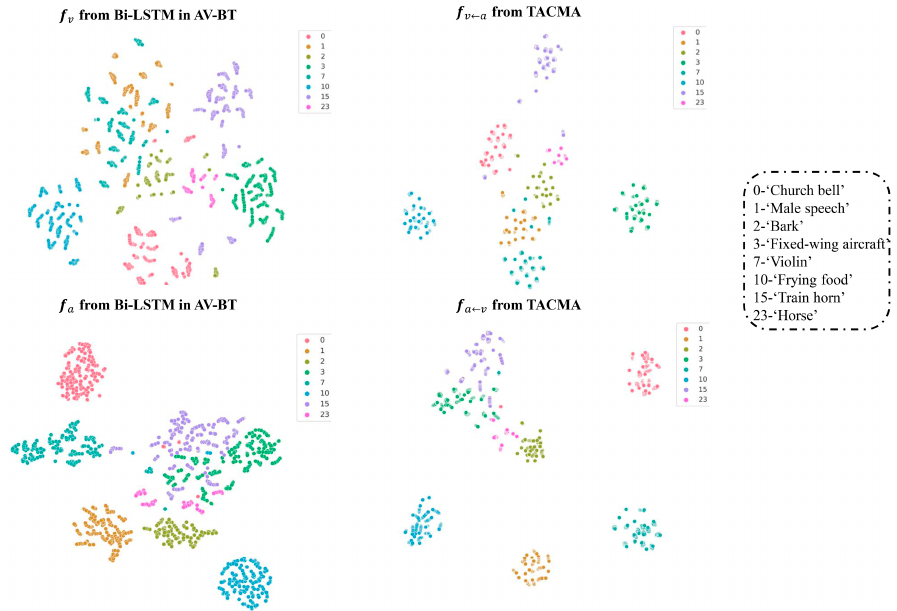
Figure 7. Illustration of the feature learning of our methods. The classes corresponding to the num‑ bers in the legends are shown in the dashed boxes on the right. Best viewed in color